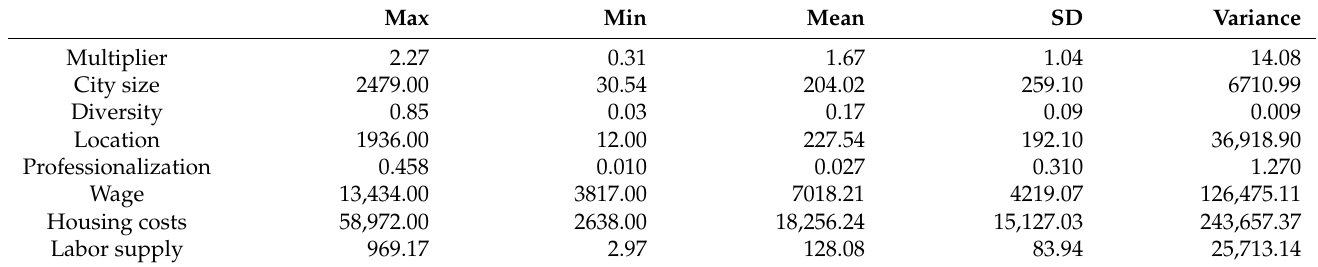
Table 2. Descriptive statistics of